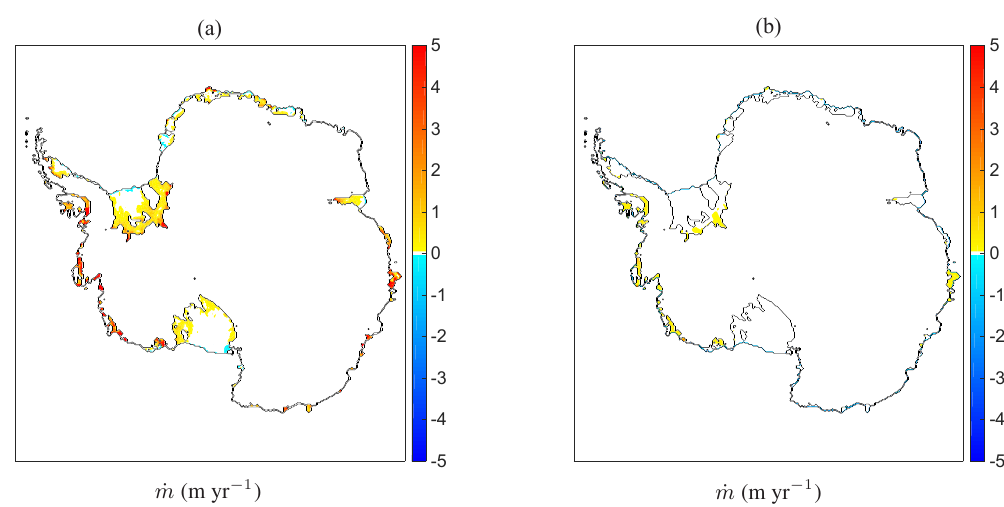
Figure 9. Basal melt rates in metres per year with the Bedmap2 topographic data and the effective temperature field of Fig. 7b as obtained from (a) the plume parametrization with additional input parameters from Fig. 4 and (b) the quadratic parametrization of DeConto and Pollard (2016).